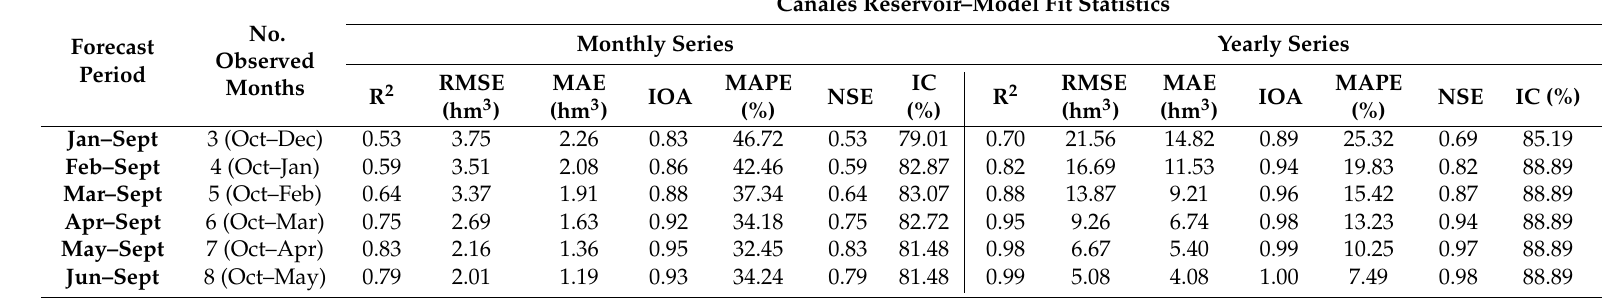
Table 4. Qu é ntar reservoir: Performance test